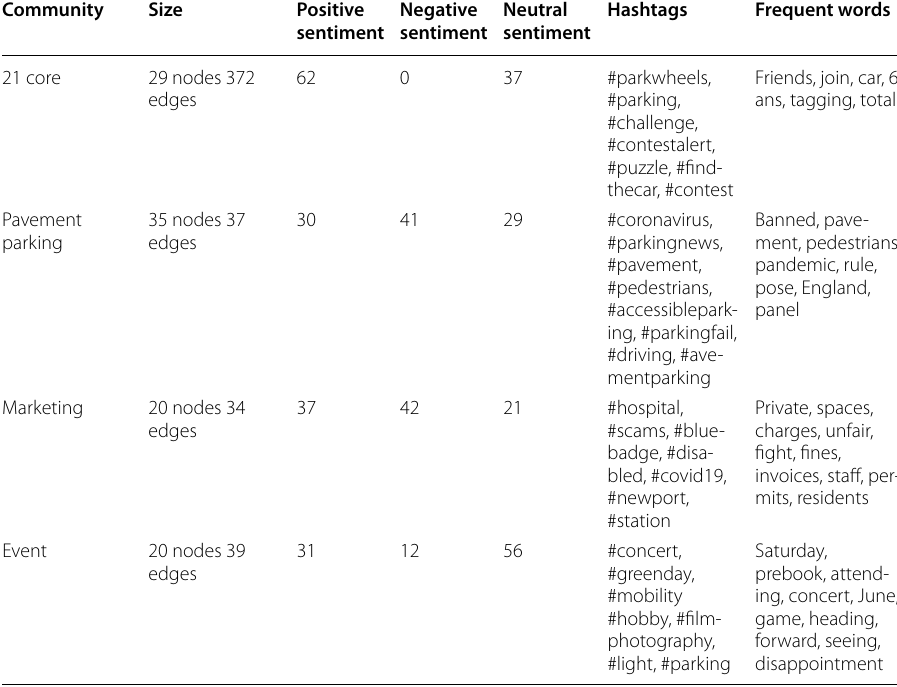
Table 11 Summary of the communities with their sentiment